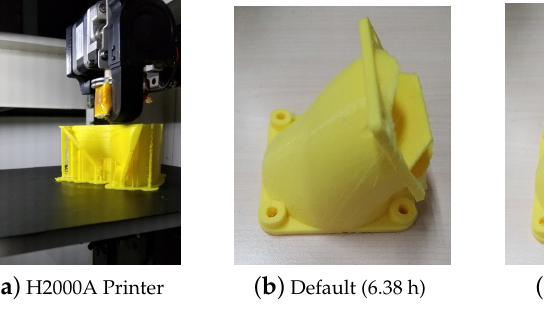
Figure 13. Printing results by H2000A